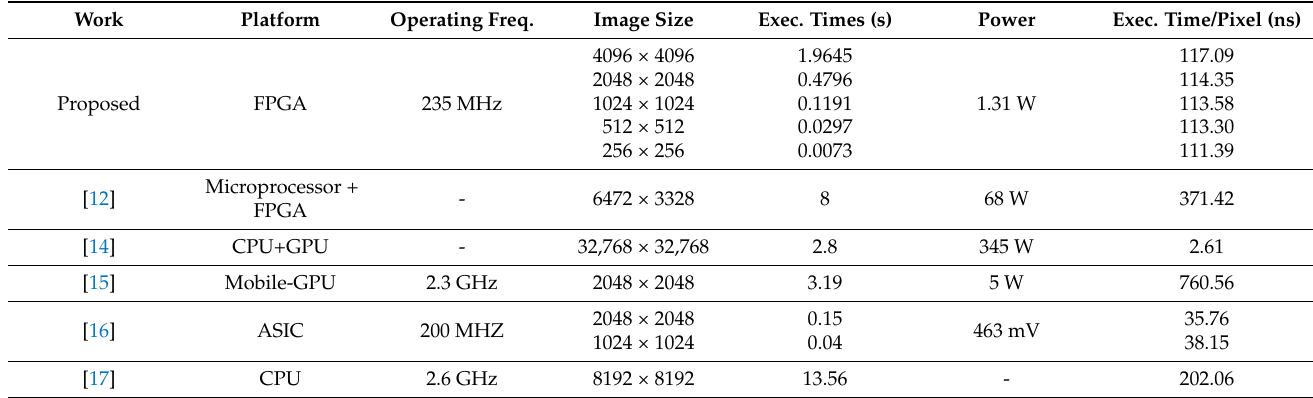
Table 3. Comparison with previous implementation.